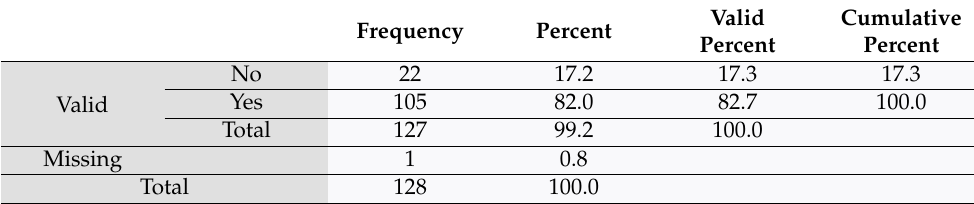
Table 6. If Yes, did you